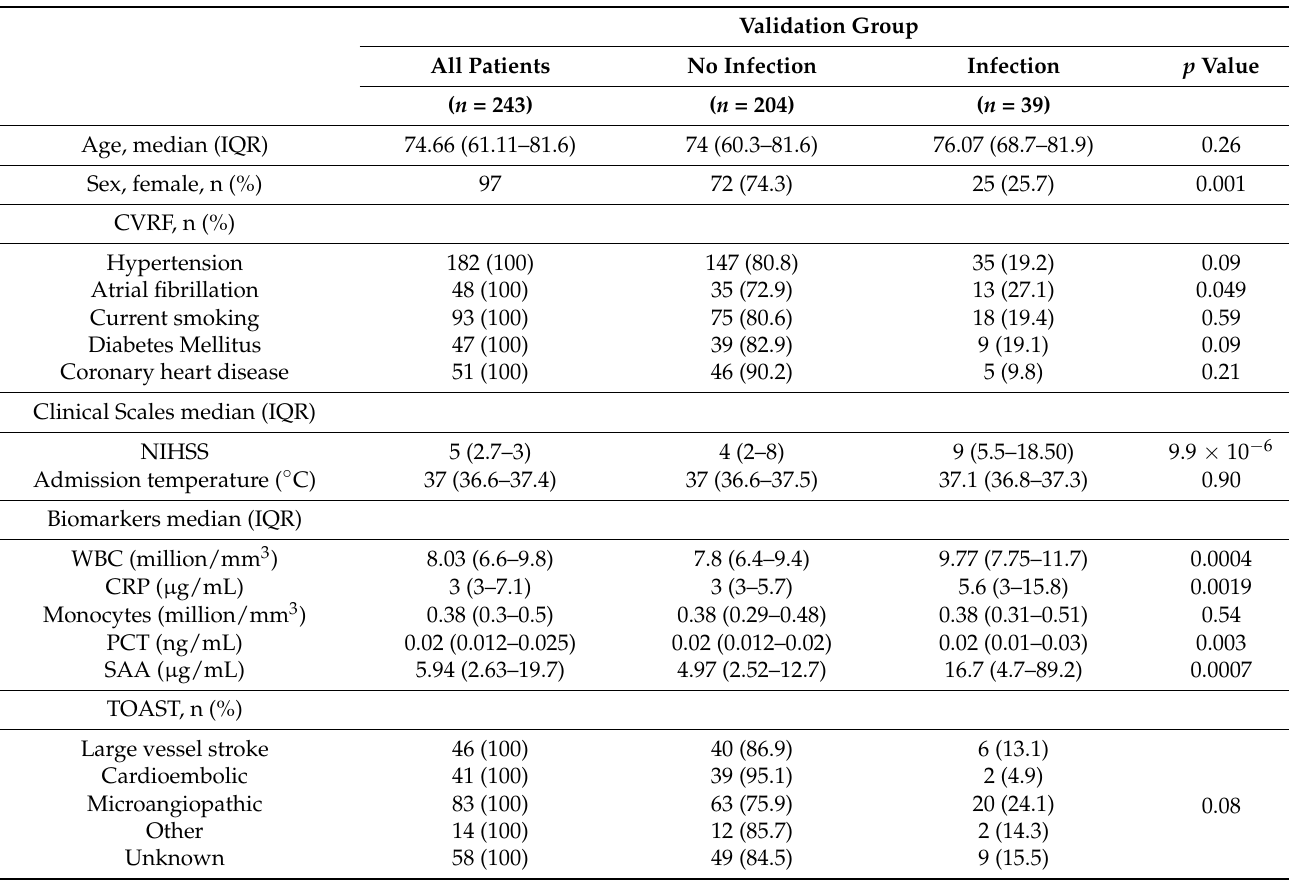
Table 2. Demographic characteristics of the validation subgroup including 204 non-infected and 39 infected